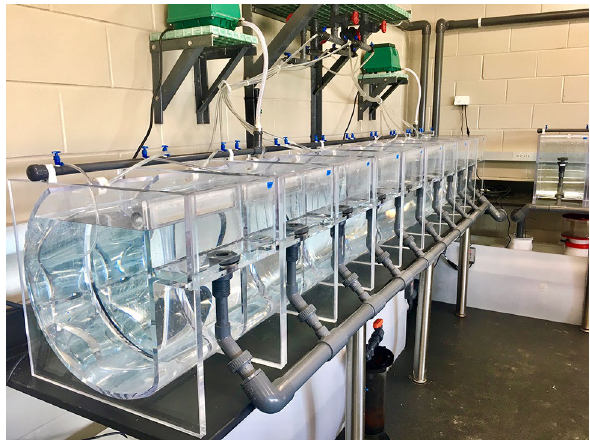
Figure 2. Photograph depicting configuration of the 1800-L recirculating larviculture system used to rear D. antillarum